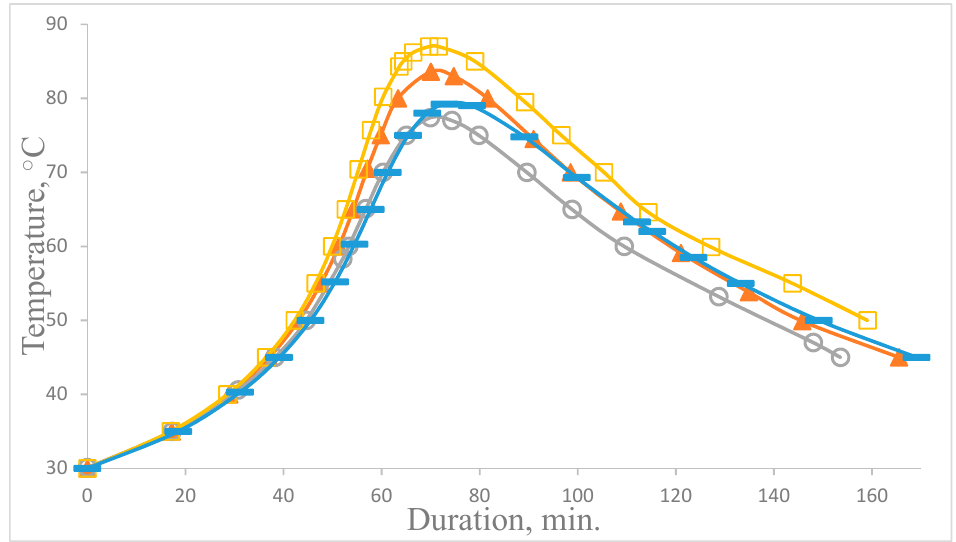
Figure 6. Kinetic curves of epoxy composite curing: ▲ —ED-20 + BR + PEPA; ○ —ED-20 + BR + PEPA + GO; □ —ED-20 + BR + PEPA + GO (APTES); ▬ —ED-20 + BR + PEPA + GO (aminoacetic acid) .